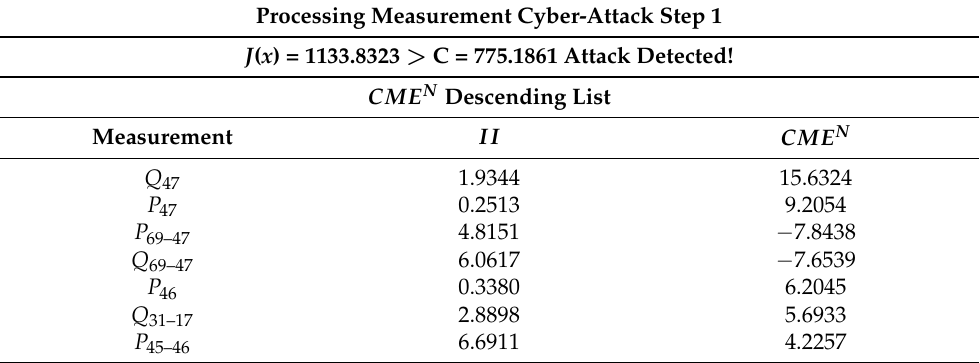
Table 3. Processing Cyber-attacks.